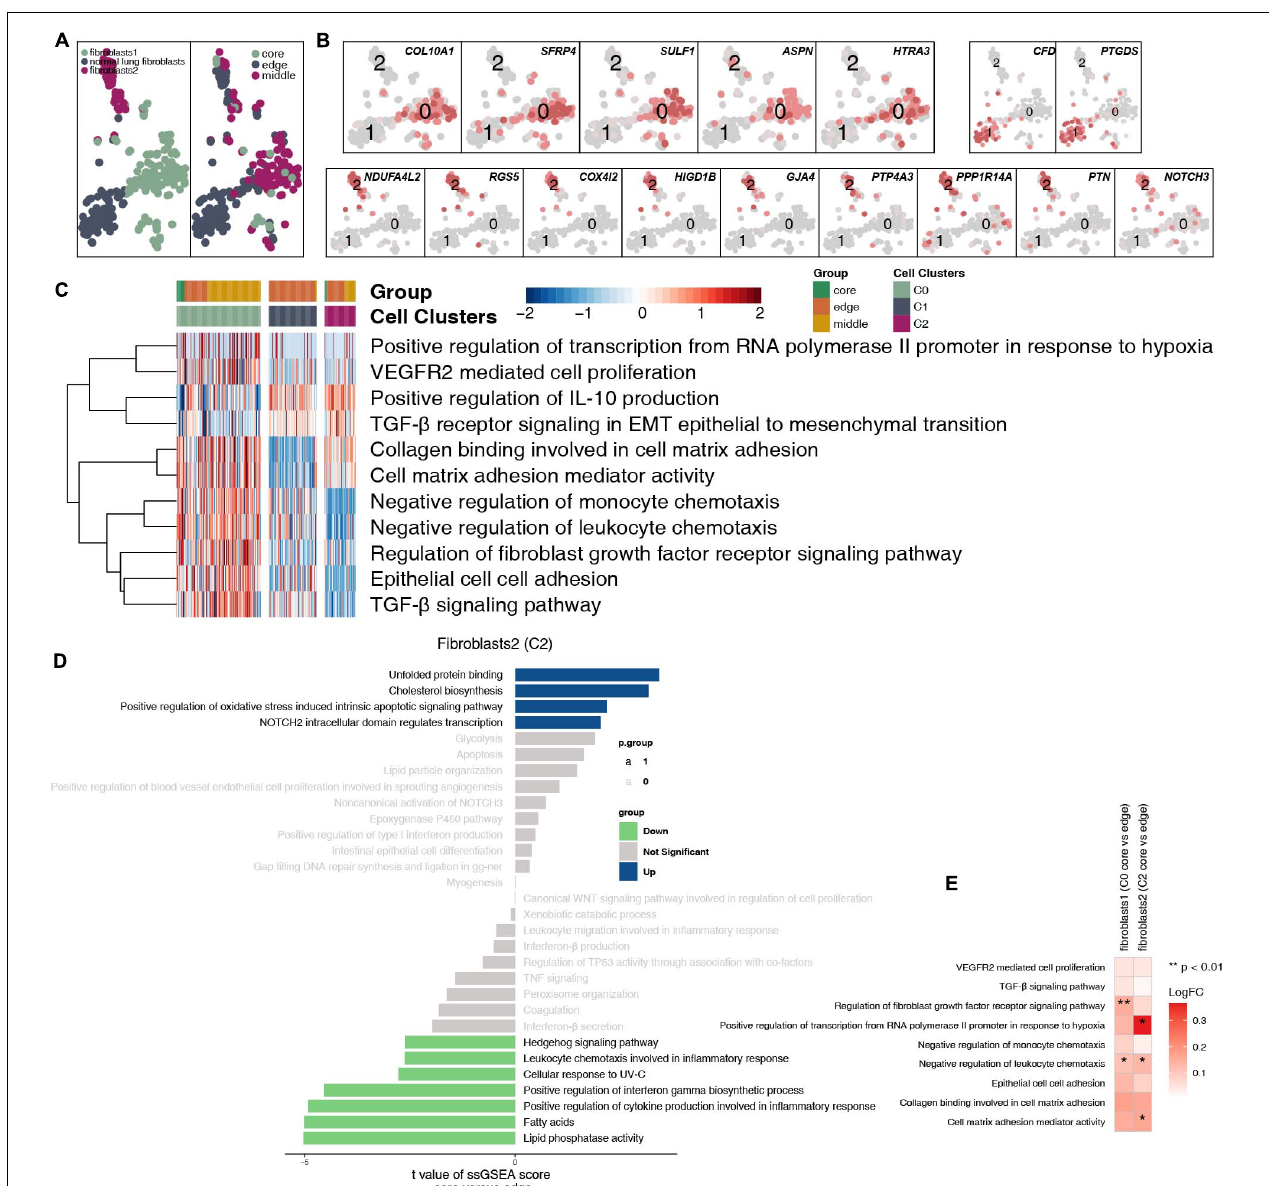
FIGURE 7 | Fibroblast clusters in LUAD. (A) tSNE plot of 259 fibroblasts, which are color-coded by their associated cluster or the sample location. (B) tSNE plot, which is color-coded for expression of marker genes for the cell types, as indicated. (C) Heatmap of the ssGSEA score, as estimated using gene sets from MsiDB, for three fibroblast clusters from fibroblasts (cluster 0), normal lung fibroblasts (cluster 1), and fibroblasts (cluster 2). (D) Differences in pathway activities scored per cell by GSVA between the tumor core and tumor edge in fibroblasts (cluster 0), normal lung fibroblasts (cluster 1), and fibroblasts (cluster 2). T -values are from a linear model. (E) Heatmap depicting the mean differences in pathway activities scored per cell by GSVA between the tumor core and tumor edge across fibroblasts (cluster 0), normal lung fibroblasts (cluster 1), and fibroblasts (cluster 2). The x -axis of the heatmap indicates different fibroblast clusters, and the y -axis indicates pathway activities scored per cell by GSVA. Each square represents the fold change or difference in each indicated pathway activity scored per cell by GSVA between the tumor core and tumor edge across fibroblasts (cluster 0), normal lung fibroblasts (cluster 1), and fibroblasts (cluster 2). Red indicates upregulation, while blue indicates downregulation. * P < 0.05; ** P <